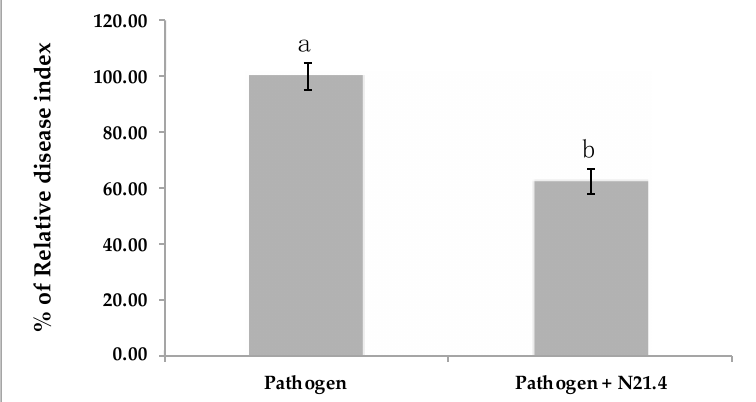
Figure 1. Relative disease index in 6-week-old tomato plants. Pathogen: plants challenged with the leaf spot pathogen Xanthomonas campestris . Pathogen + N21.4: plants treated with Pseudomonas fluorescens N21.4 and challenged with the leaf spot pathogen Xanthomonas campestris . Disease was recorded 1 week after pathogen challenge. Bars indicate standard errors ( n = 20). Different letters denote statistically significant differences ( p < 0.05).